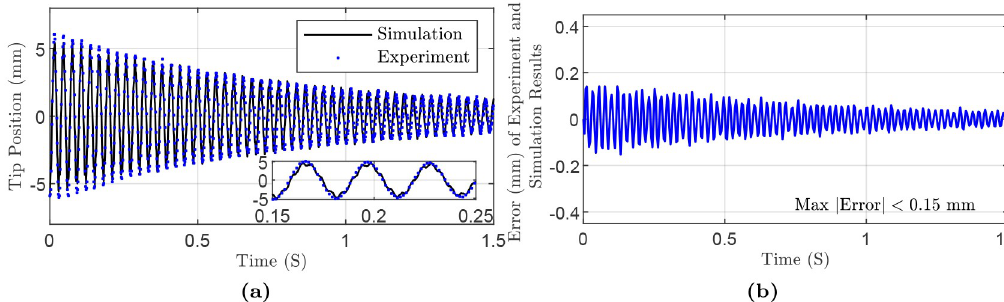
Fig 6. Simulation and experiment results for flexible rod (AlSi05), in-plane experiment: (a) Tip position in E Inset highlights the results in a small time range. (b) Error in E